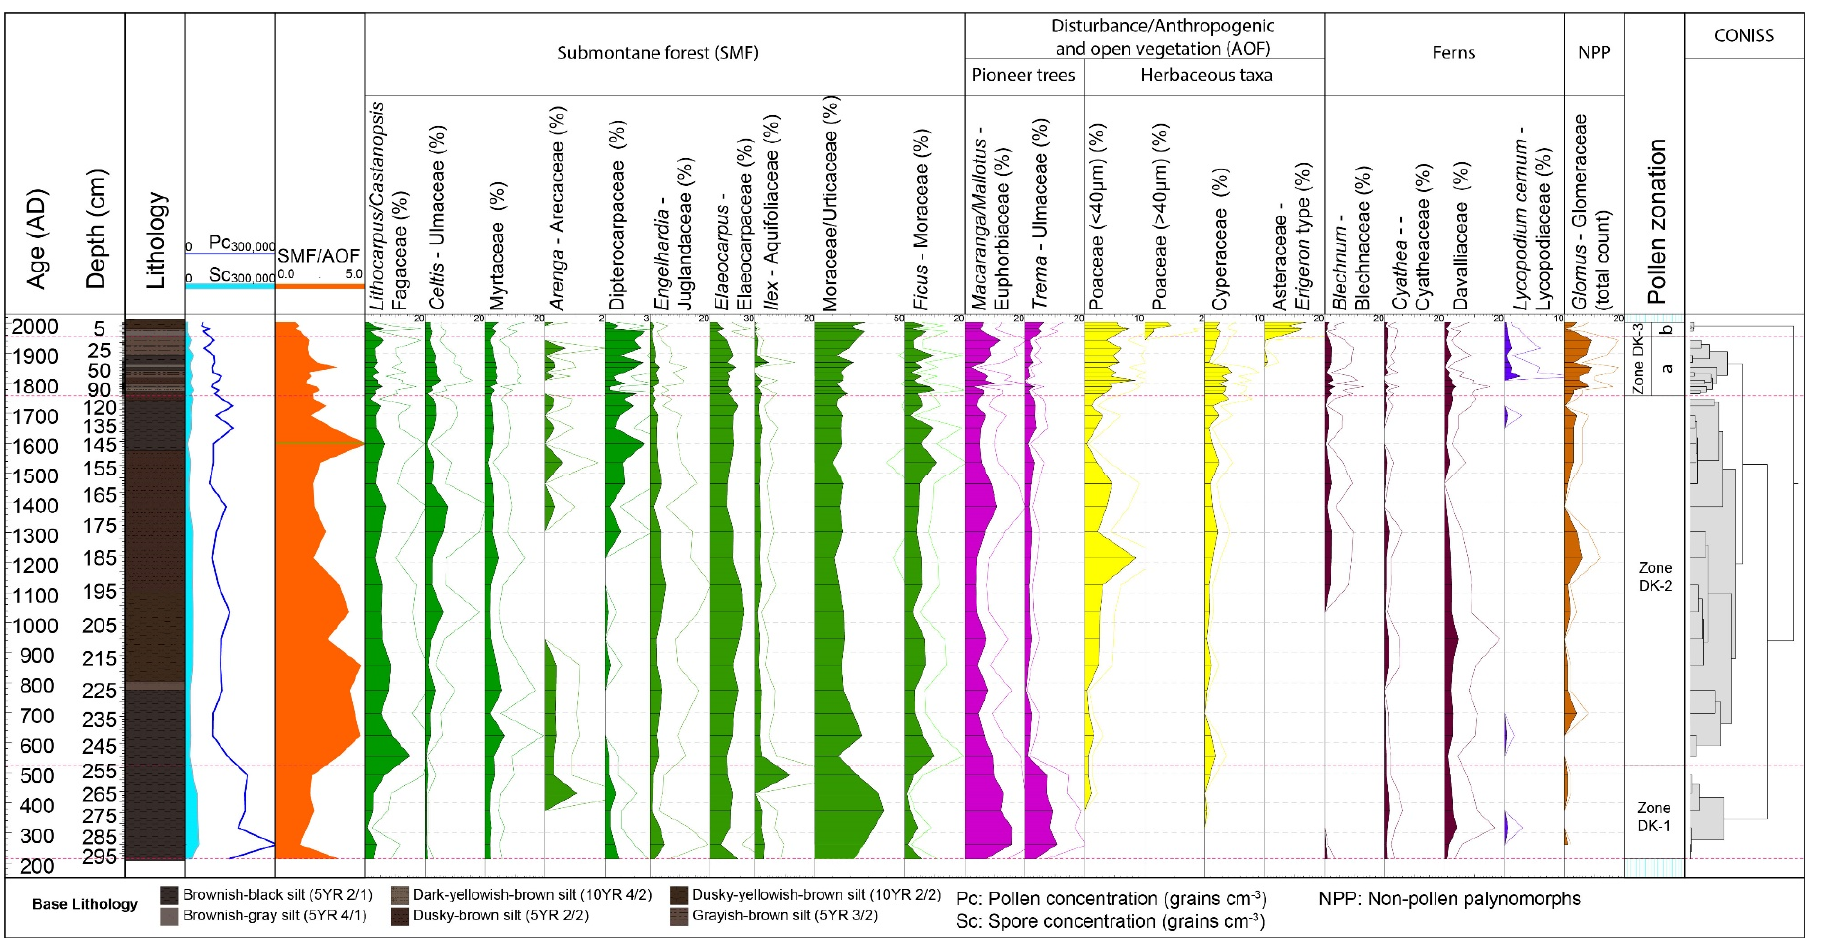
Figure 3. A palynological diagram of the DK core with lithology. The most important pollen and spore taxa are expressed as the percentages of the total sum of pollen (pollen taxa) and pollen plus spores (ferns). NPP-Glomus is expressed as the absolute total count.